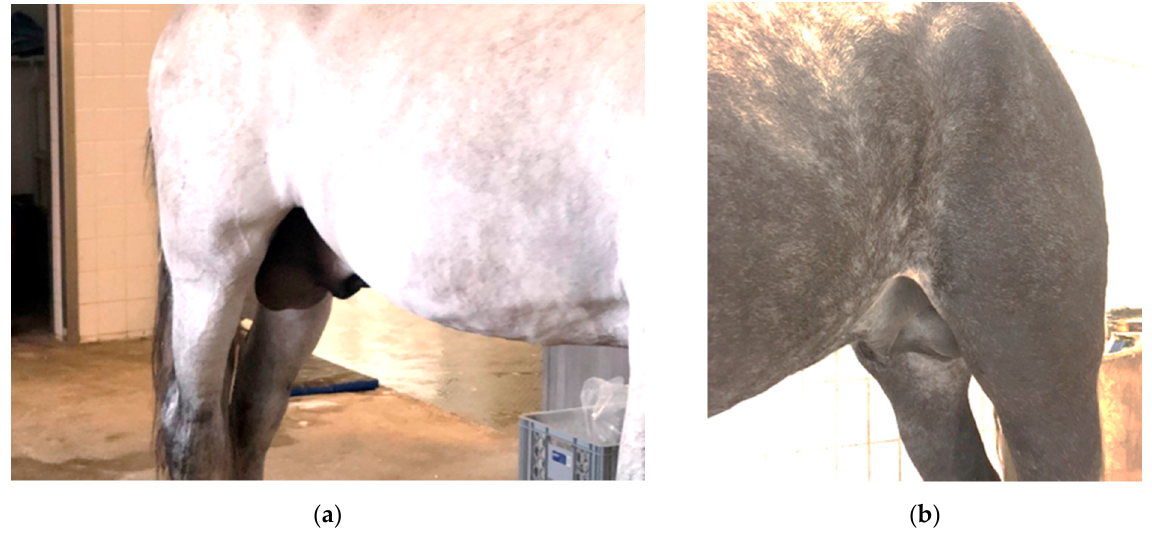
Figure 1. ( a ) extensive scrotal swelling in this 12-year-old PRE stallion (index case); ( b ) age- and size-matched control (9-year-old draft horse (Percheron) stallion). Furthermore, note the (subjectively) extensive distention of peripheral blood vessels of the chest and limb in the index case.